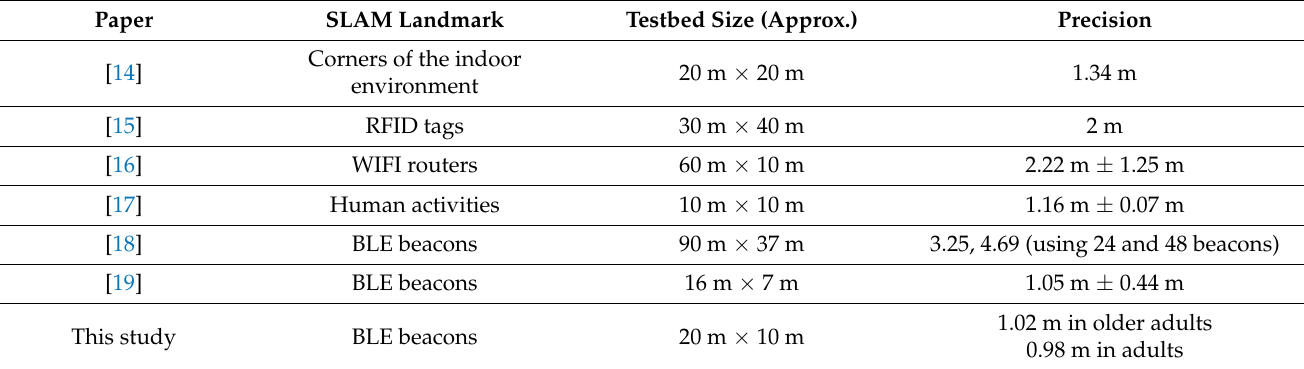
Table 9. Comparison with related